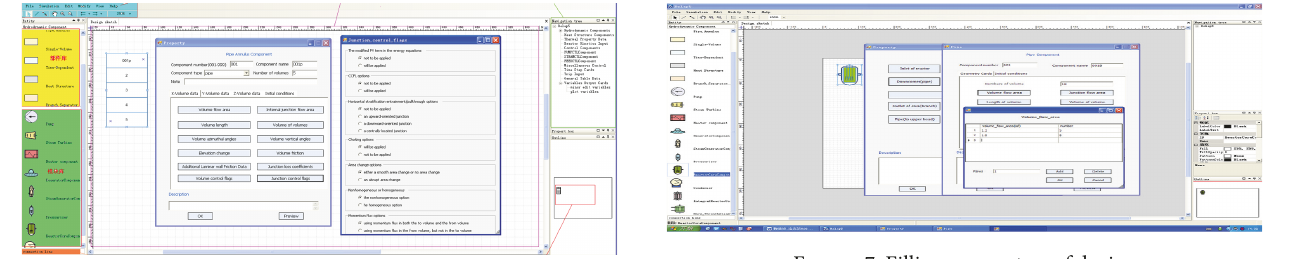
Figure 7: Filling parameters of device.